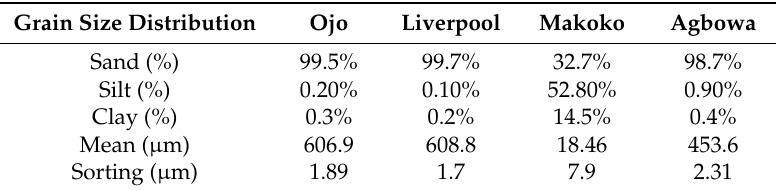
Figure 4. Size distribution of tentative MP particles (visual analysis) in the water and sediment samples of the four sampling sites. Table 1. Grain size distribution purple, red, transparent, turquoise, white, and yellow. The most common colours of tentative MPs were transparent (41%) and black (30%) for sediments and black (40%), blue (23%), and transparent (22%) for the water samples.